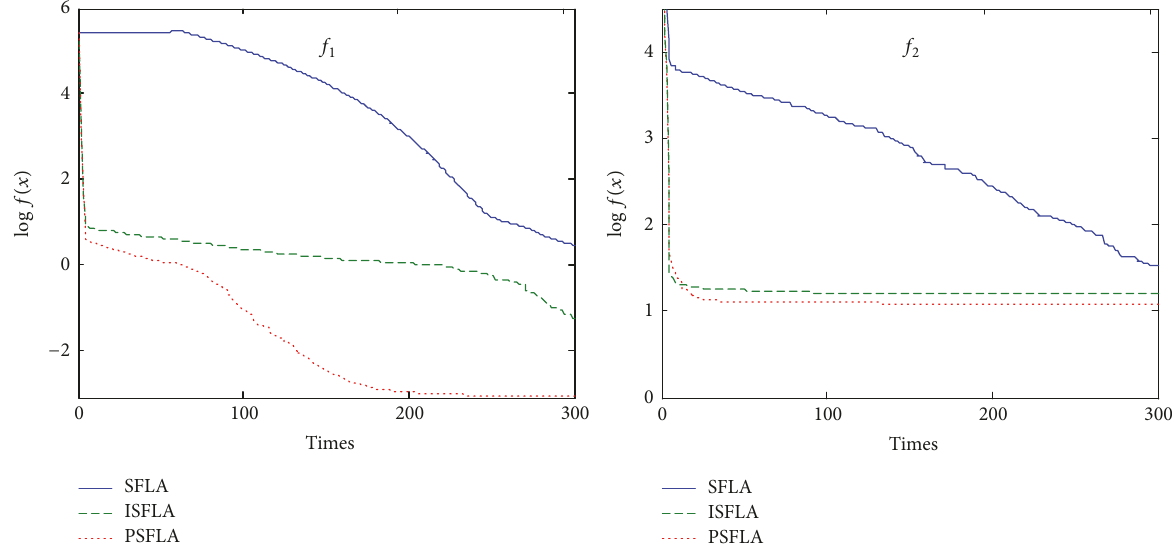
Figure 4: The evolutionary